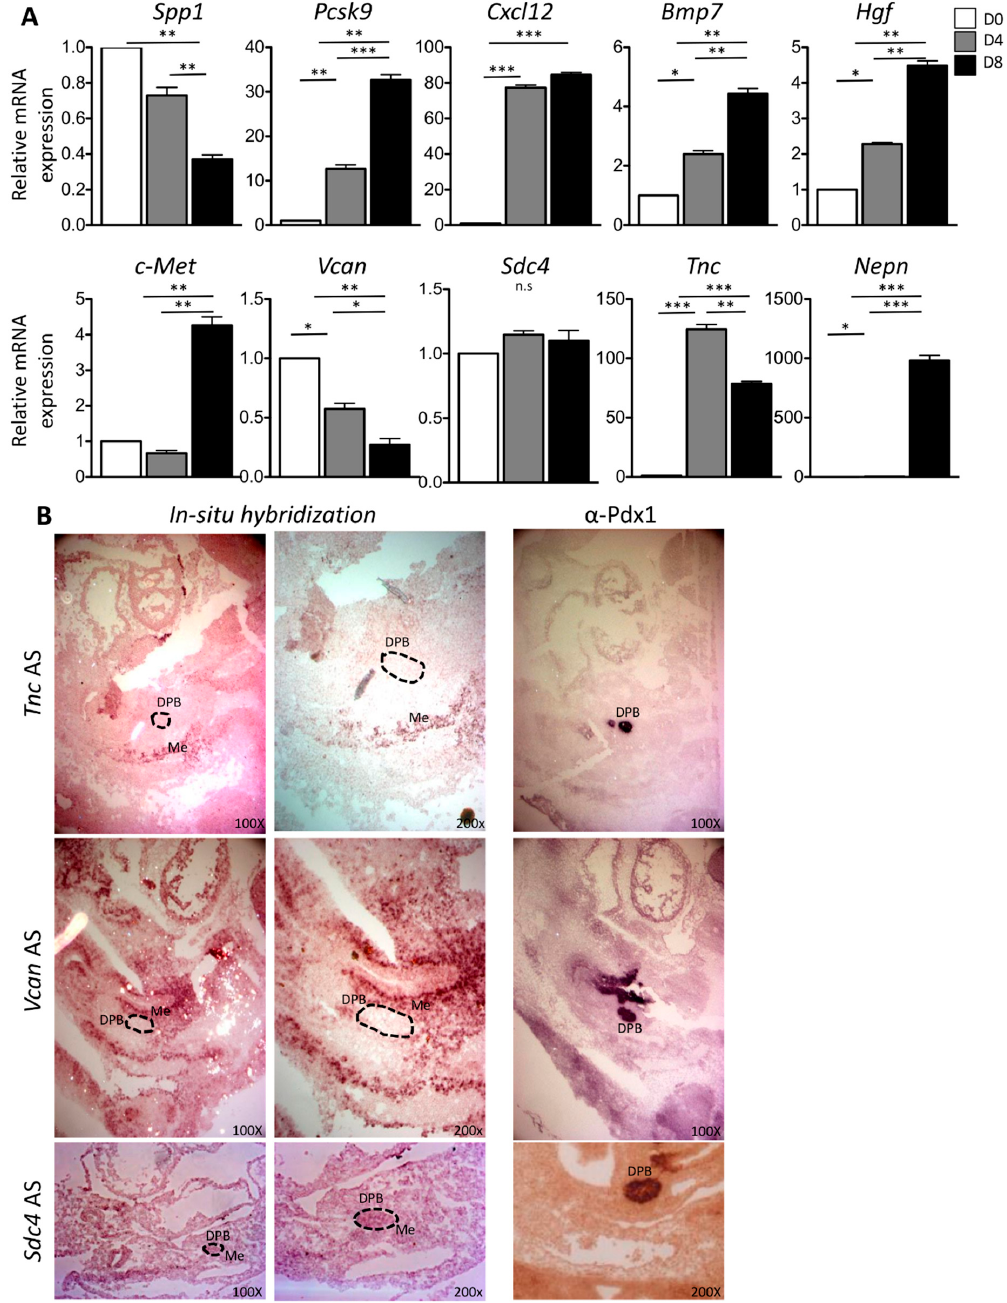
Figure 4. ( A ) RT qPCR of the selected novel candidate genes for DPB and MeDPB crosstalking (Spp1, Pcsk9, Cxcl12, Bmp7, Hgf, c-Met, Vcan, Sdc4, Tnc) during mESCs di ff erentiations. Nepn expression is used as bona fide marker for pancreatic di ff erentiation. Gapdh expression level is used as reference gene. The data reported are normalized on Gapdh expression. Statistical analyses were performed using Student’s t -test, with p < 0.05 considered significant. (* p < 0.05, ** p < 0.01, *** p < 0.001, n.s p > 0.05). Values are shown as means of three independent RT-qPCR experiments ± SD in triplicates. ( B ) In situ hybridization for candidate MeDPB genes on mouse embryos at E10.5. In situ hybridization was performed on frozen sections with a probe recognizing Vcan, Tnc, and Sdc4 genes. Vcan and Tnc are expressed in the mesenchyme surrounding pancreatic bud and Sdc4 is expressed in the pancreatic bud. For each probe, two di ff erent magnifications are shown: 100 × and 200 × . Right column shows ISH for Pdx1 on the serial slides. DPB: dorsal pancreatic bud (indicated by dark circle), Me: mesenchyme. Data are representative of three independent